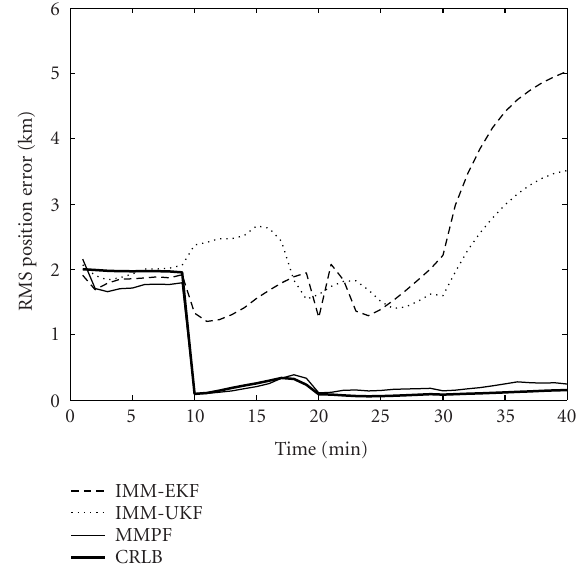
Figure 5: RMS position error versus time for a multisensor